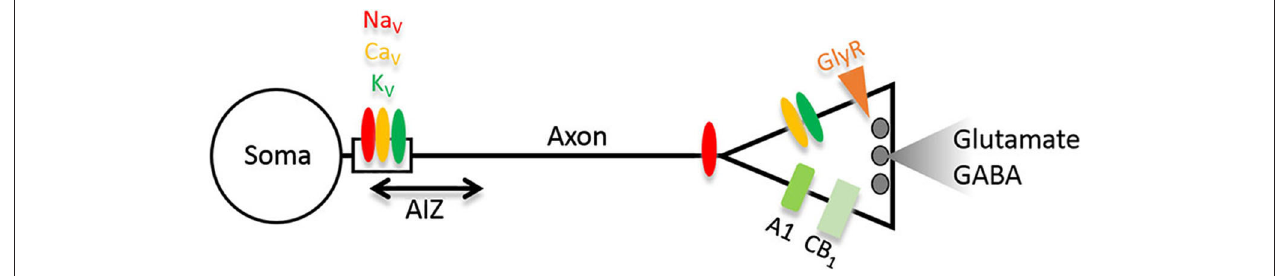
decrease it. The opposite holds true if the changes occur in GABAergic neurons. Abbreviations: Na V , Ca V , K V , voltage-gated sodium, calcium and potassium channels; AIZ, action potential (AP) initiation zone; GlyR, glycine receptors; A1, adenosine receptor; CB 1 , cannabinoid receptor